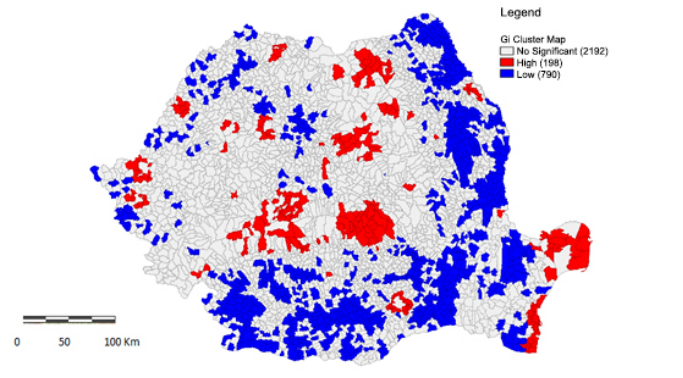
Figure 5: Categories of significant spatial associations of LAUs in terms of number of accommodation